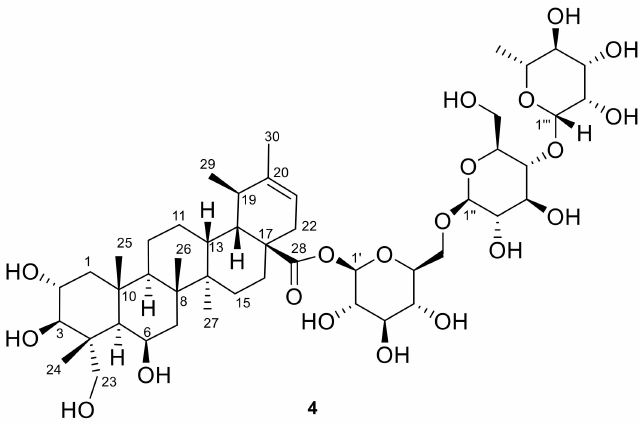
Figure 2. The chemical structure of the new isomadecassoside ( 4